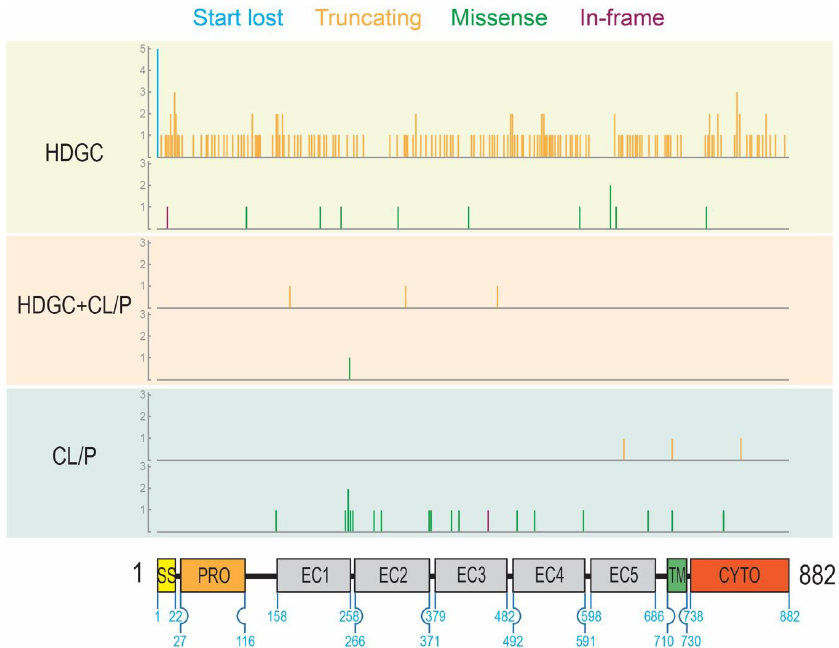
Figure 1. Location of all variants with respect to the epithelial cadherin (E-cadherin) domain structure grouped by mutation type and phenotype (HDGC: hereditary diffuse gastric cancer; CL/P: cleft lip/palate). Variant positions are marked by vertical lines that correspond on the x-axis to the amino acid residue number. The height of the vertical lines corresponds to the number of variants located at that given residue position (y-axis). The color of the vertical lines represents the type of variant: start lost (blue), truncating (orange), missense (green), and in-frame deletion (purple). For each phenotype, variants are grouped by type: start lost and truncating variant (upper); missense and in-frame deletion variants (lower). For reference, numbers on the schematic of the protein represent the start and end residues of each domain.